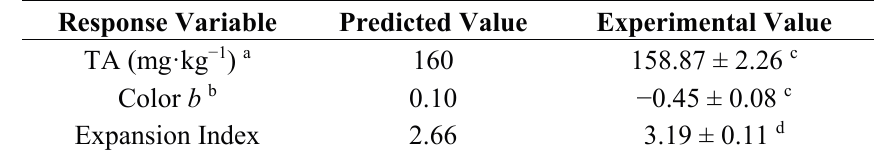
Table 3. Predicted values and experimental results of chemical and physical evaluations on the expanded nixtamalized blue corn extrudates obtained from the optimum processing